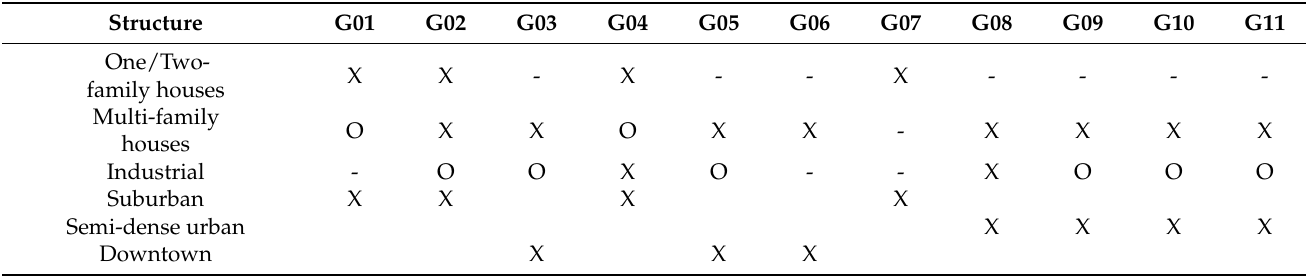
Table A2. Classification of the investigated grids in terms of the building and urban structure (X = high share, O = low share, - = negligible or not present).